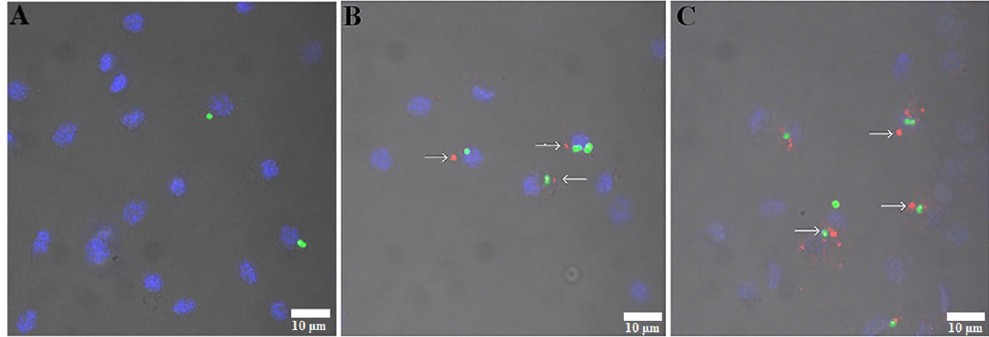
Figure 4. The short-term study of cellular immune response – phagocytosis assay. Tenebrio molitor specimens were topically exposed to saline ( A ; control) or 2 ng ( B ) or 2 µ g ( C ) of Alexa Fluor 647-h-BN-OH-n and then injected with fluorescent latex beads. Arrows show phagocytes with aggregates of Alexa Fluor 647-h-BN-OH-n (red) and fluorescent latex beads (green). Nuclei of the haemocytes were stained with DAPI (blue). Scale bars: 10 µ m.